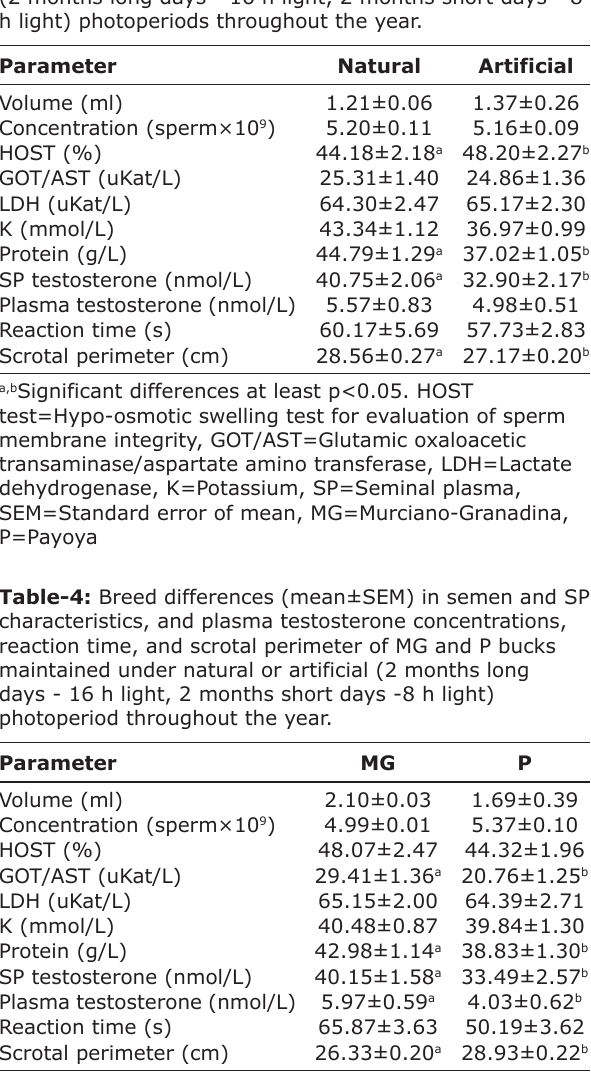
Table-3: Photoperiodic differences (mean±SEM) in semen and SP characteristics, and plasma testosterone concentrations, reaction time, and scrotal perimeter of MG and P bucks maintained under natural or artificial